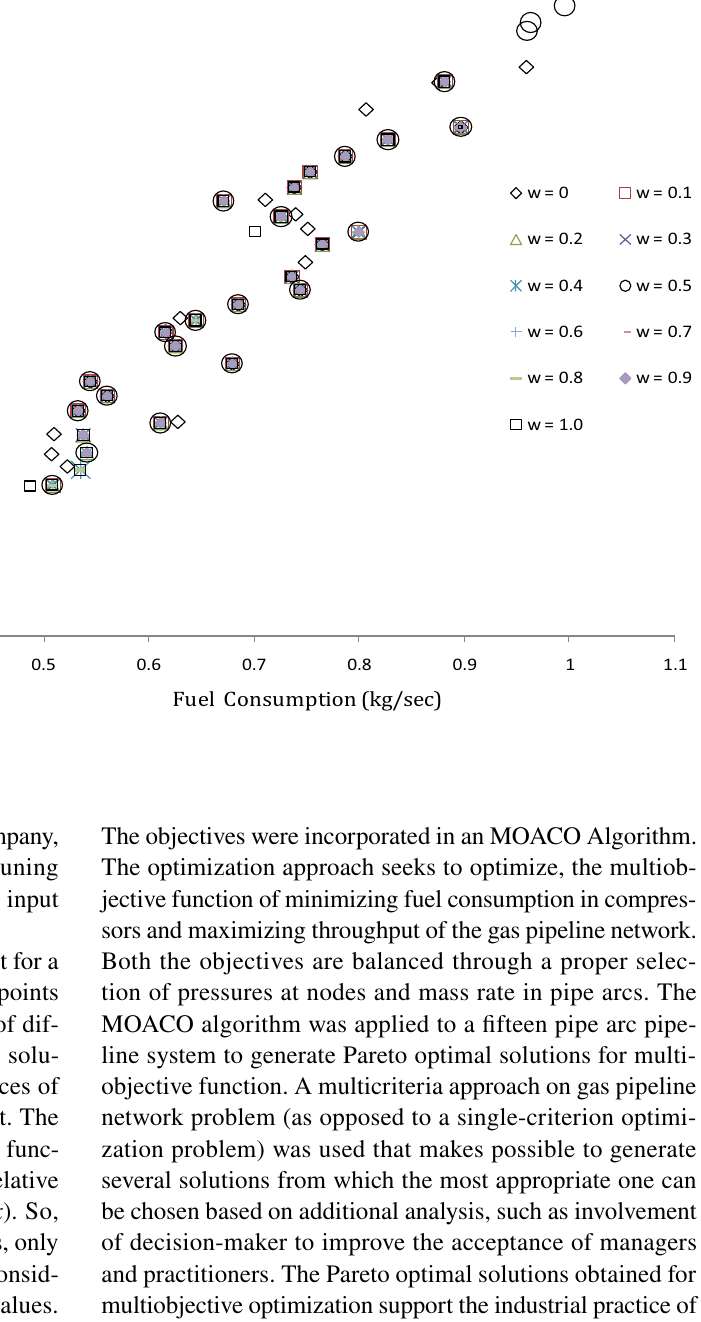
Fig. 6 Pareto front for different weights obtained using multiob- jective ant colony optimization